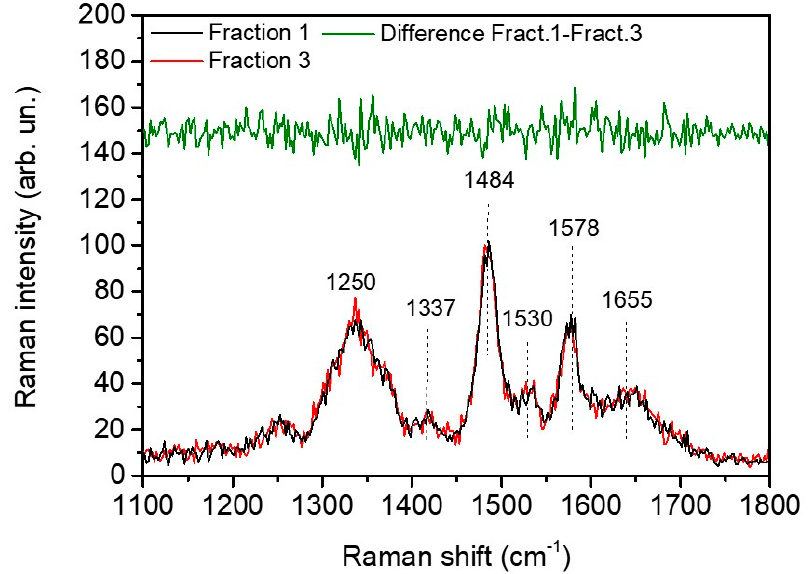
Figure 6. Average_R value: the average value of the 2853 / 2870 cm − 1 area peak ratio of the control samples, of fractions 1 and 3 of patients with high (on the right) and low motility (on the left; i.e., motility higher or lower than 40%). Control samples are depicted in black, while fractions 1 and 3 in light blue and red. The standard deviation is indicated in black over the bars. As well-reported in the graph, each ratio reported in the graph is the average value obtained choosing the patients’ fractions with a motility lower (on the left) or higher (on the right) than 40%. In particular, all the patients’ fractions with a measured motility lower than 40% have a ratio higher or close to 1, whereas the average value of the fractions with a motility higher than 40% have a ratio lower than 1.